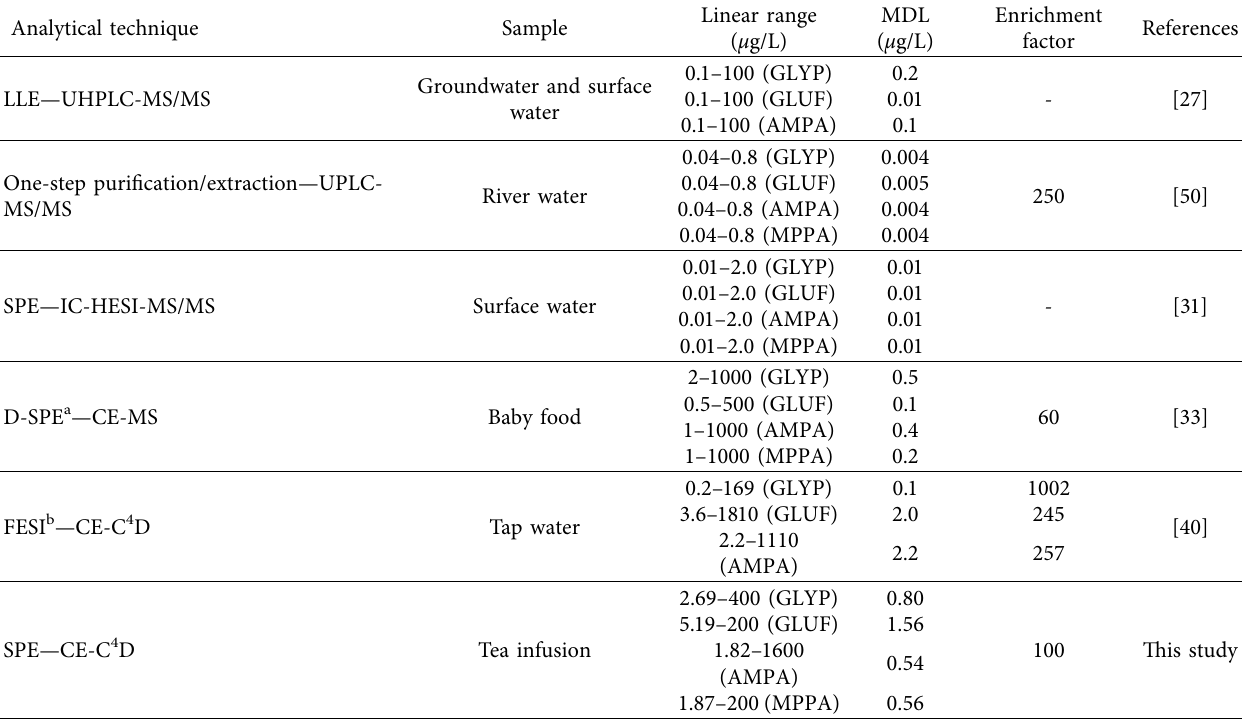
Table 2: Comparison of different analytical methods applied for the determination of GLYP, GLUF, AMPA, and MPPA. Analytical